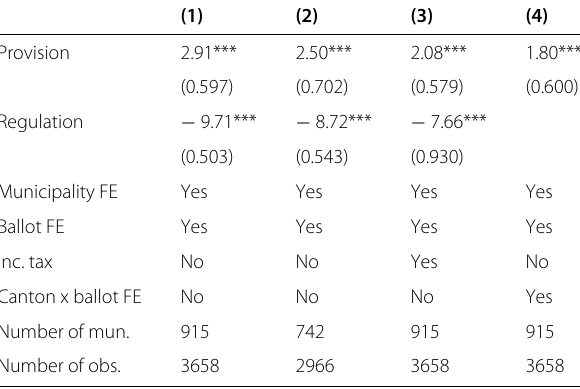
Table 1 DiD estimates: effect of lunchtime and after-school care on vote